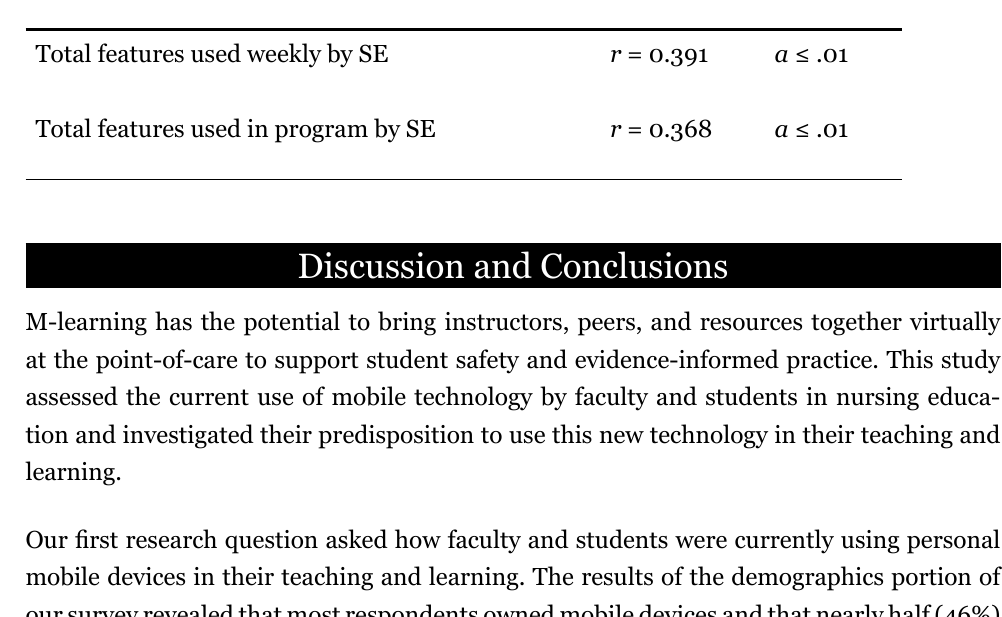
Number of Mobile Features Use and